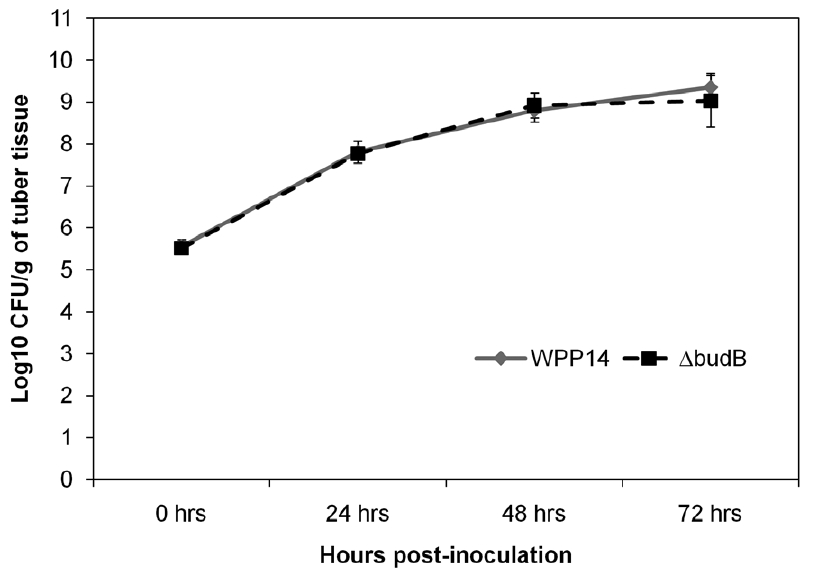
Figure 5. WPP14 D budB is not impaired in growth in potato tubers. Bacterial suspensions containing 10 5 CFU were stab-inoculated into potato tubers (cv. ‘‘Superior’’) ( n =5). Tubers were placed into plastic bags and incubated at 28 u C. Bacterial population was determined every 24 hrs after inoculation. Error bars indicate standard error. The graph shows data from one of two experiments, neither of which showed significant difference in bacterial growth.